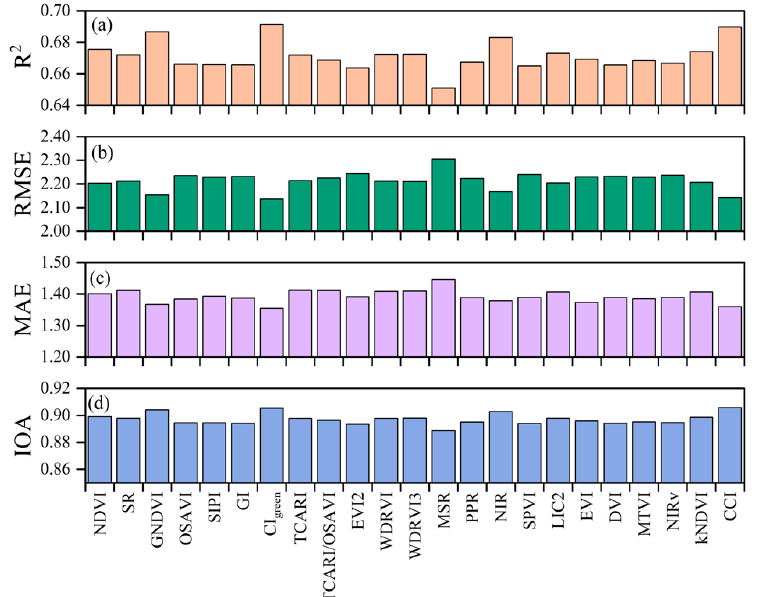
Figure 4. (a) The coefficient of determination (R 2 ), (b) the root-mean-square error (RMSE) (gC/m 2 /d), Figure 4. ( a ) The coefficient of determination (R 2 ), ( b ) the root-mean-square error (RMSE) (gC/m 2 /d), (c) the mean absolute error (MAE) (gC/m 2 /d), and (d) the index of agreement (IOA) of GPP simula- ( c ) the mean absolute error (MAE) (gC/m 2 /d), and ( d ) the index of agreement (IOA) of GPP simula- tions based on different vegetation indices. tions based on different vegetation